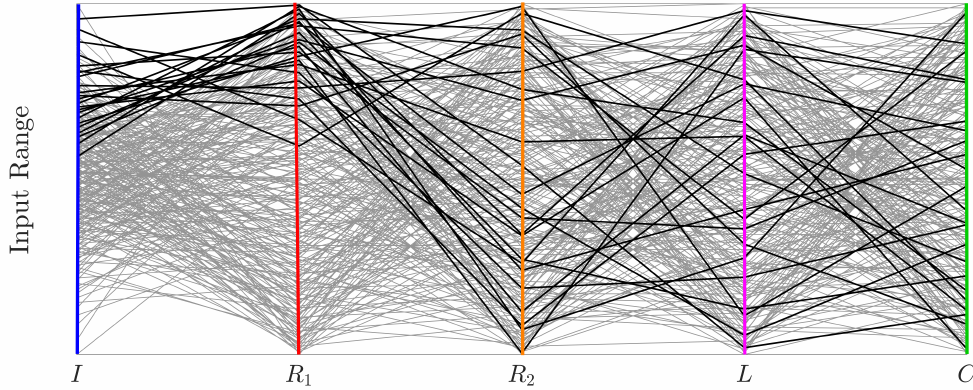
Figure 14. Cobweb plots of the five inputs at t = 40 ms. Each vertical line represents the standardized variation range of one input. The grey trajectories represent all the different combinations of the input values. The black trajectories highlight the input combinations leading to v C > 50